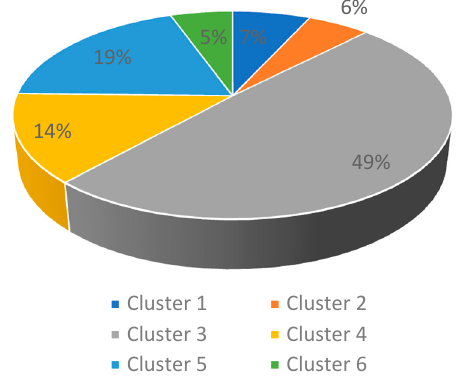
Figure 4. Distribution of clients per cluster.